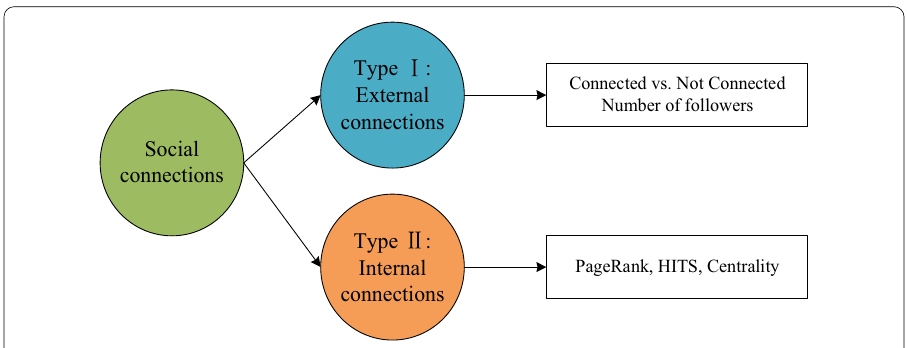
Fig. 2 Classification of social